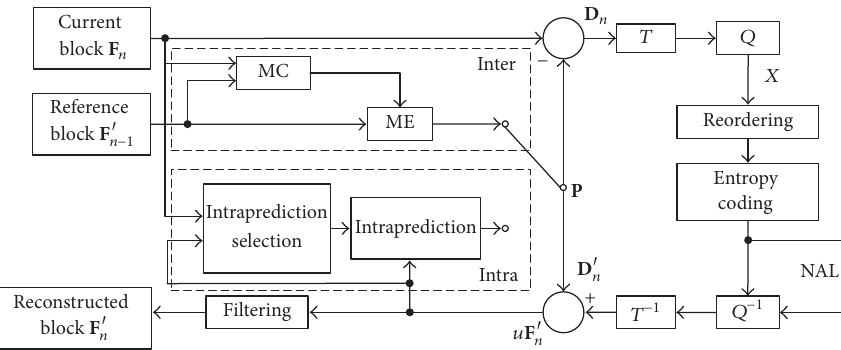
Figure 1: H.264 codec